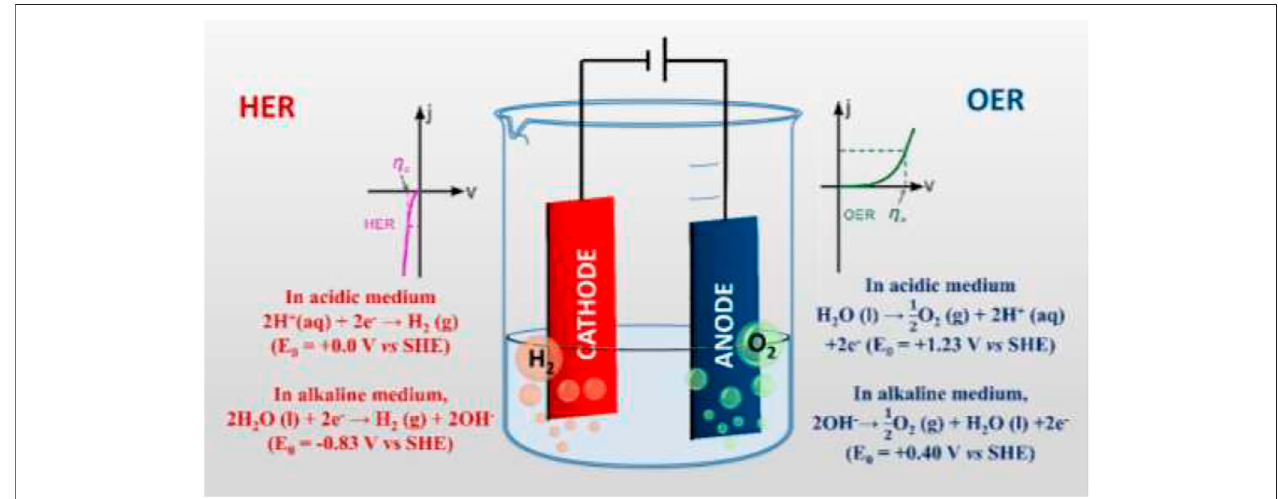
FIGURE 1 | Schematic illustration of the electrochemical water-splitting reaction and related reaction kinetics.